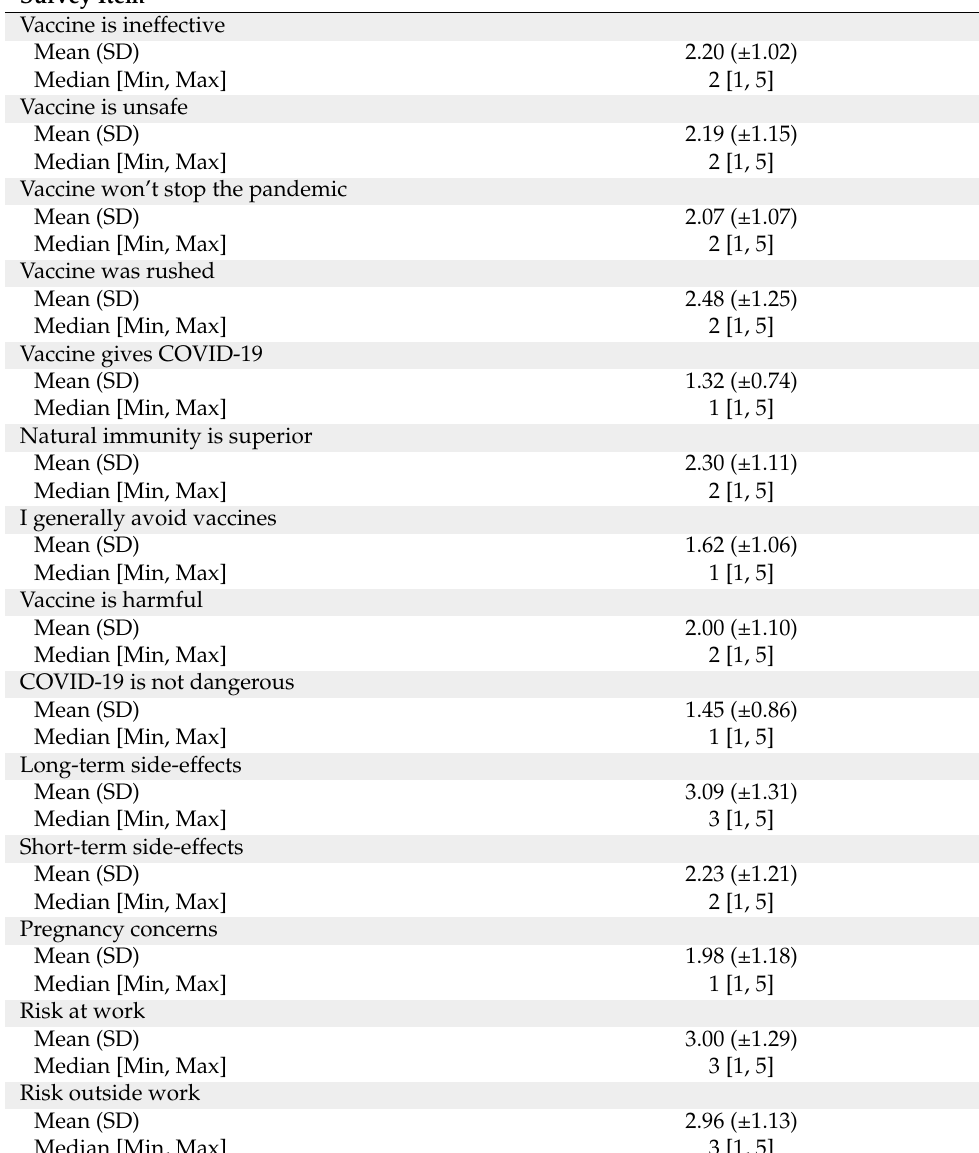
Table 2. Survey Item Responses (N =